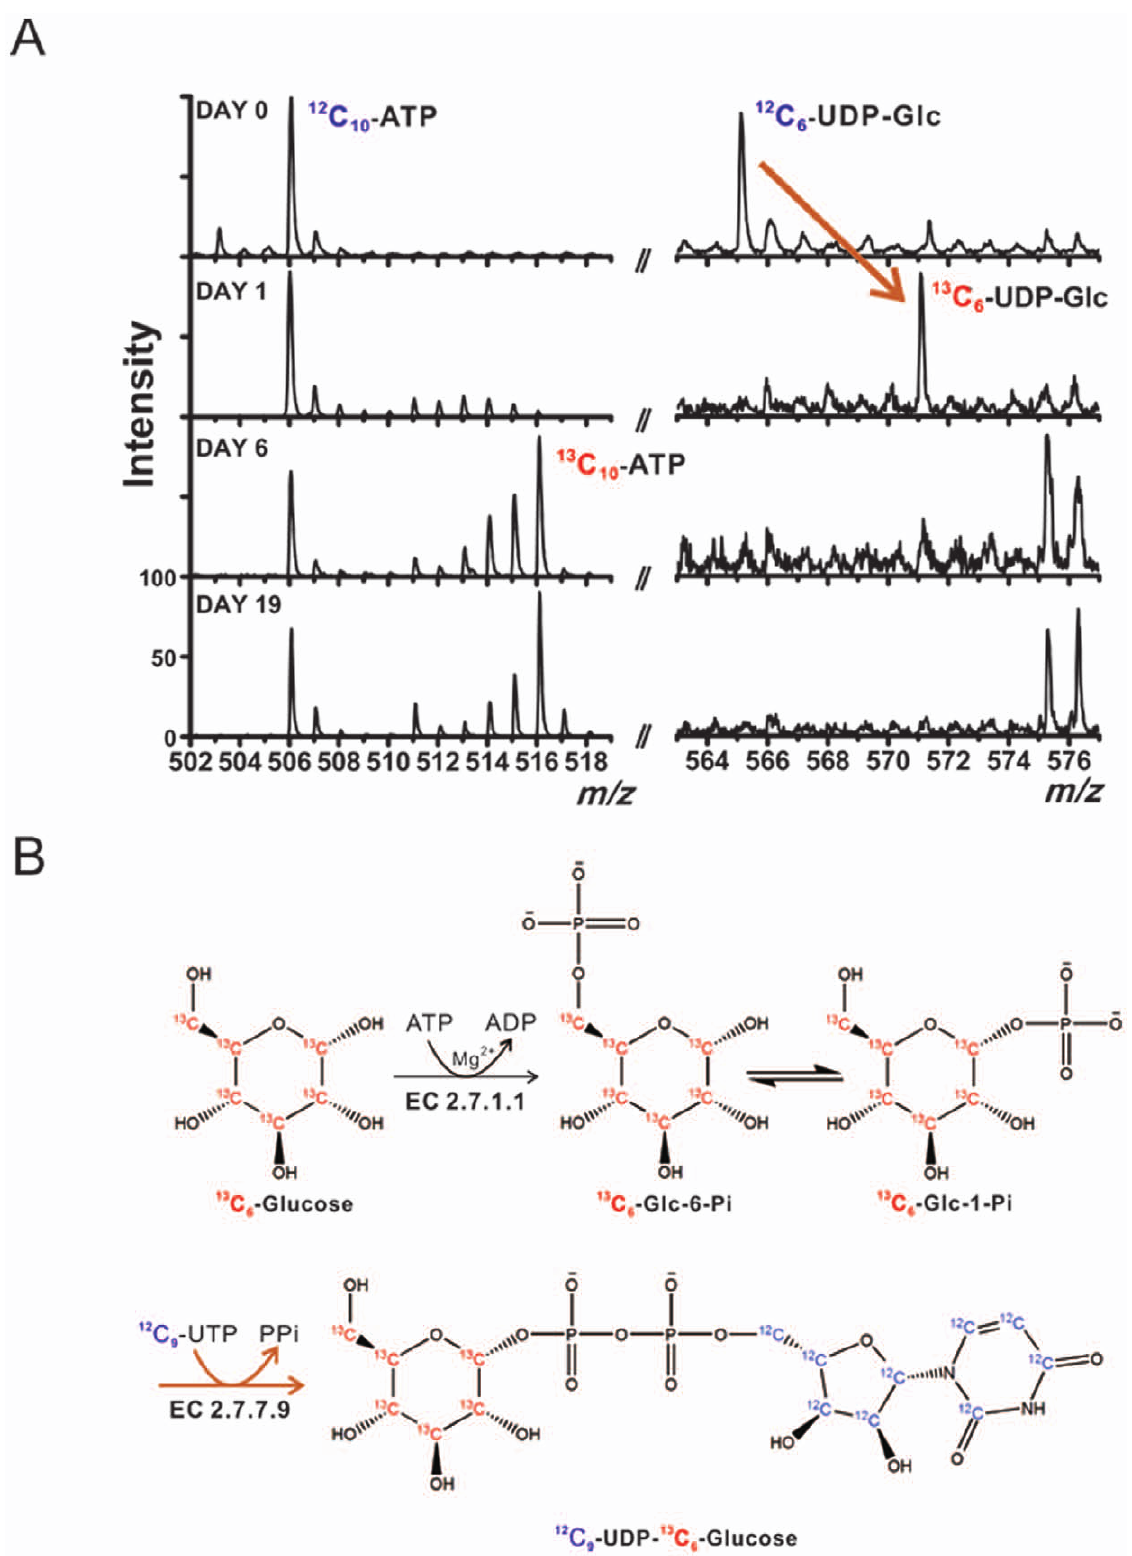
Figure 2. Isotopic labeling of ATP and UDP-glucose in single eggs. (A) MALDI mass spectra obtained from fruit flies following 1, 6, and 19 days of incubation with the 13 C 6 -glucose solution. (B) Reaction scheme of labeling glucose moiety in UDP-glucose with 13 C 6 -glucose.